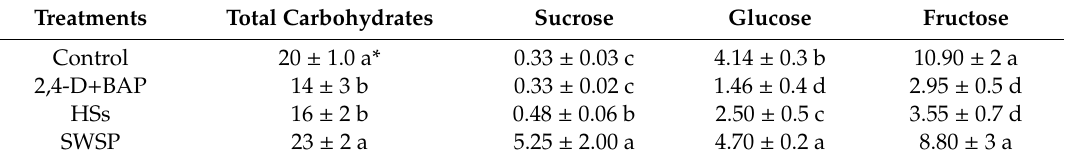
Table 3. Total carbohydrates, sucrose, glucose, fructose (mg mL − 1 ) content in Pinus laricio callus grown for 28 d with hormones or humic substances (HSs) or soil water soluble phenolic fraction (SWSP). Treatments Total Carbohydrates